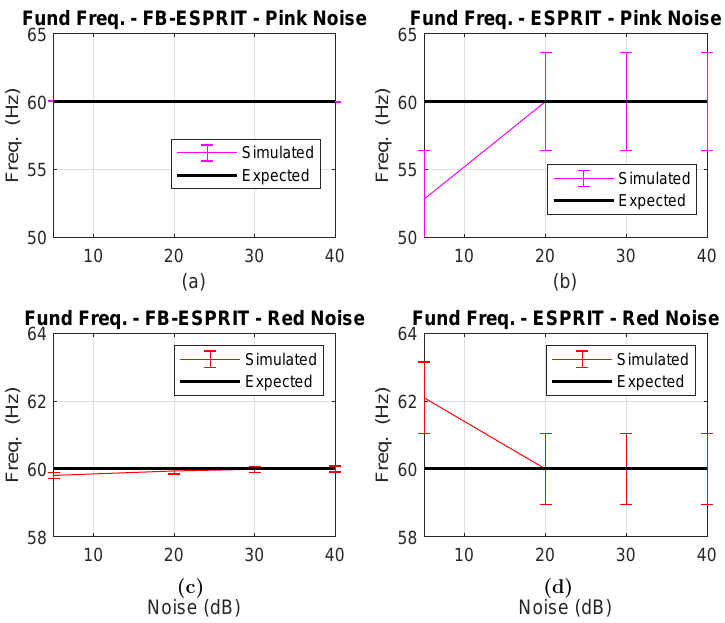
Figure 7. Estimation of fundamental frequency (Fund Freq.) when s 1 ( t ) is contaminated with pink and red noises; ( a ) by FB-ESPRIT under pink noise, ( b ) by ESPRIT under pink noise, ( c ) by FB-ESPRIT under red noise, and ( d ) by ESPRIT under red noise.